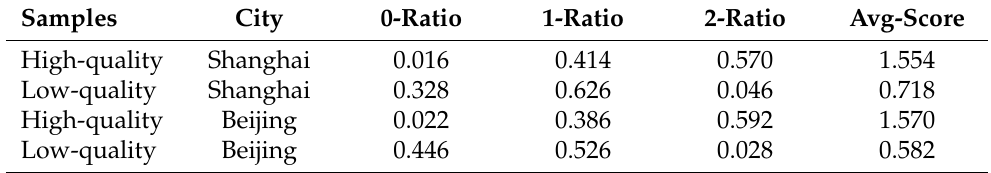
Table 5. Human evaluation on data quality of sampling data tagged by calibration